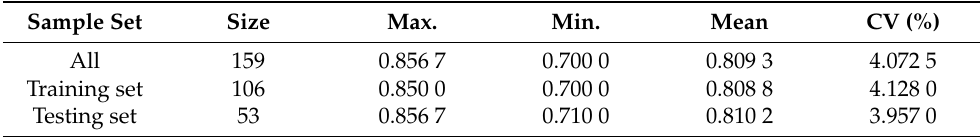
Table 2. Statistical characteristics of Fv/Fm for all sample set, training set and test set.